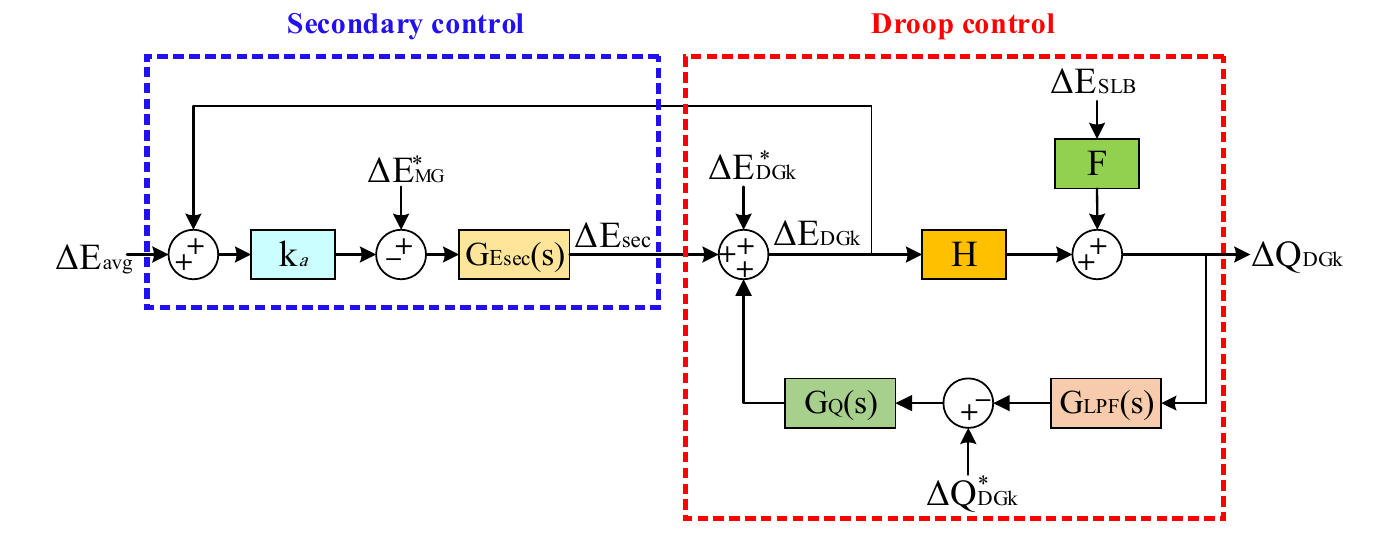
Figure 4. Small signal model of voltage distributed controller for DG k .